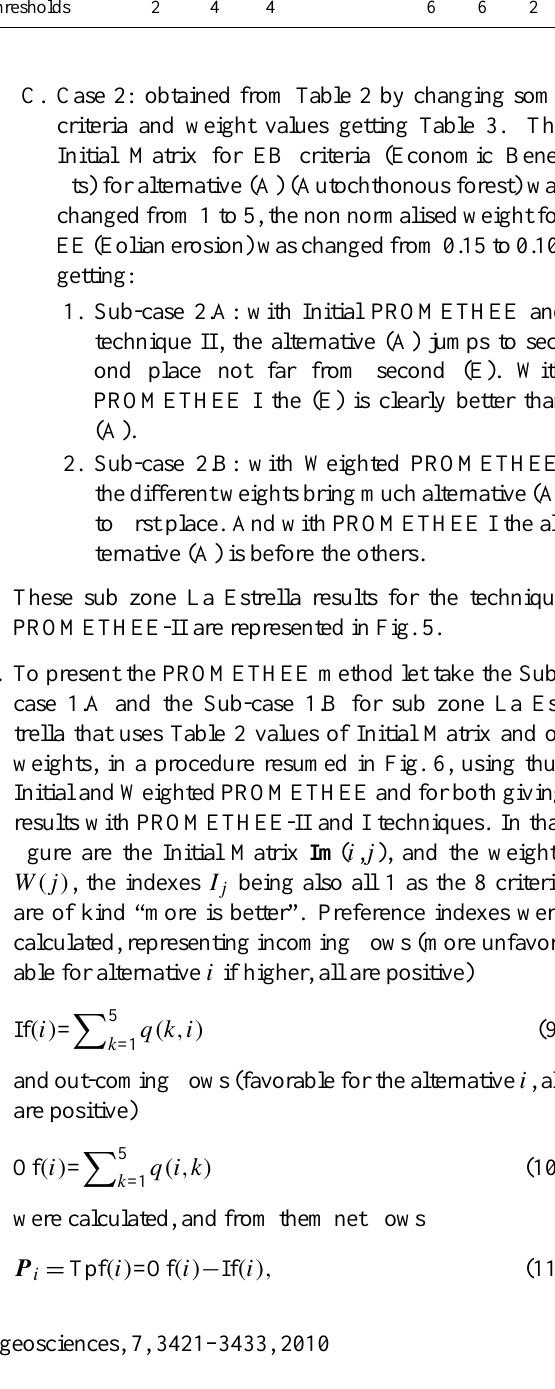
Fig. 5. Pre-order of alternatives selected by PROMETHEE-II meth- ods to sub zone La